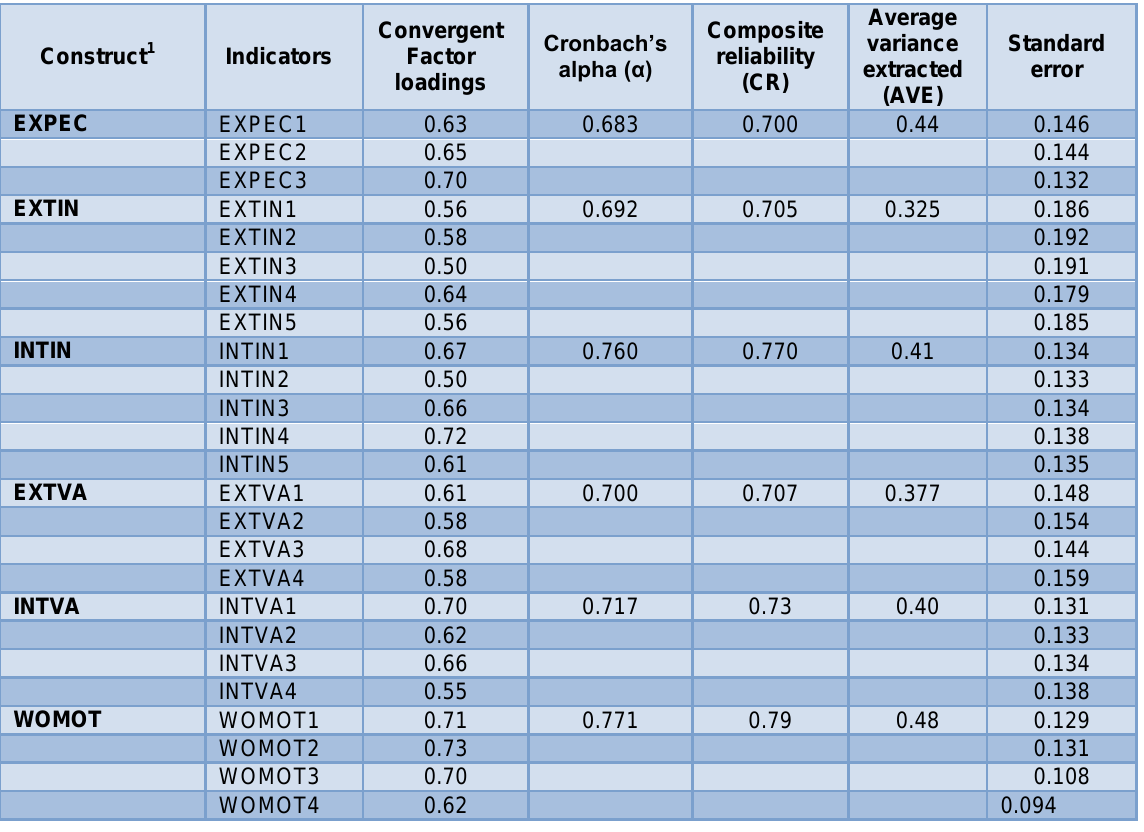
Table 3 Results of the confirmatory factor analysis